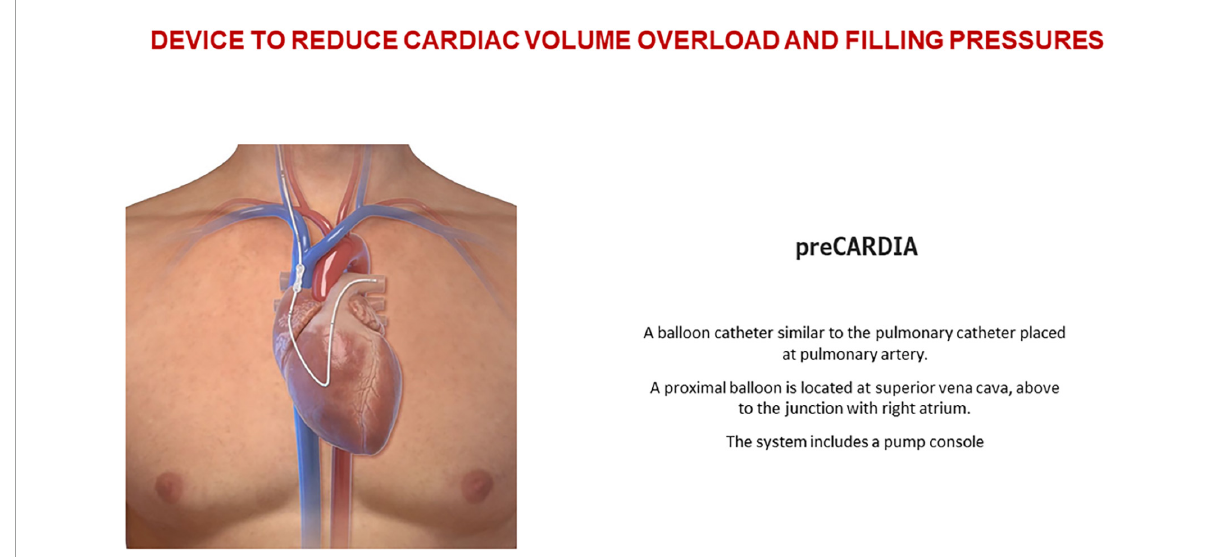
FIGURE5 Puller device for heart failure. The preCardia. Image used with permission from